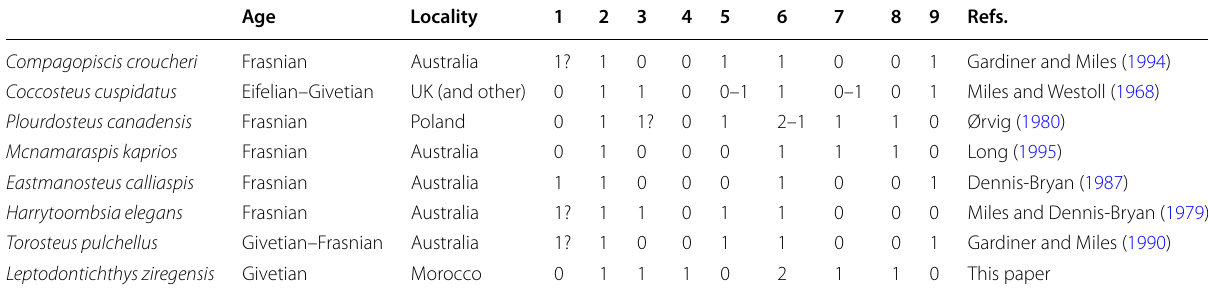
Table 2 Morphological character matrix of posterior superognathals of eubrachythoracids including information on the age and locality of the